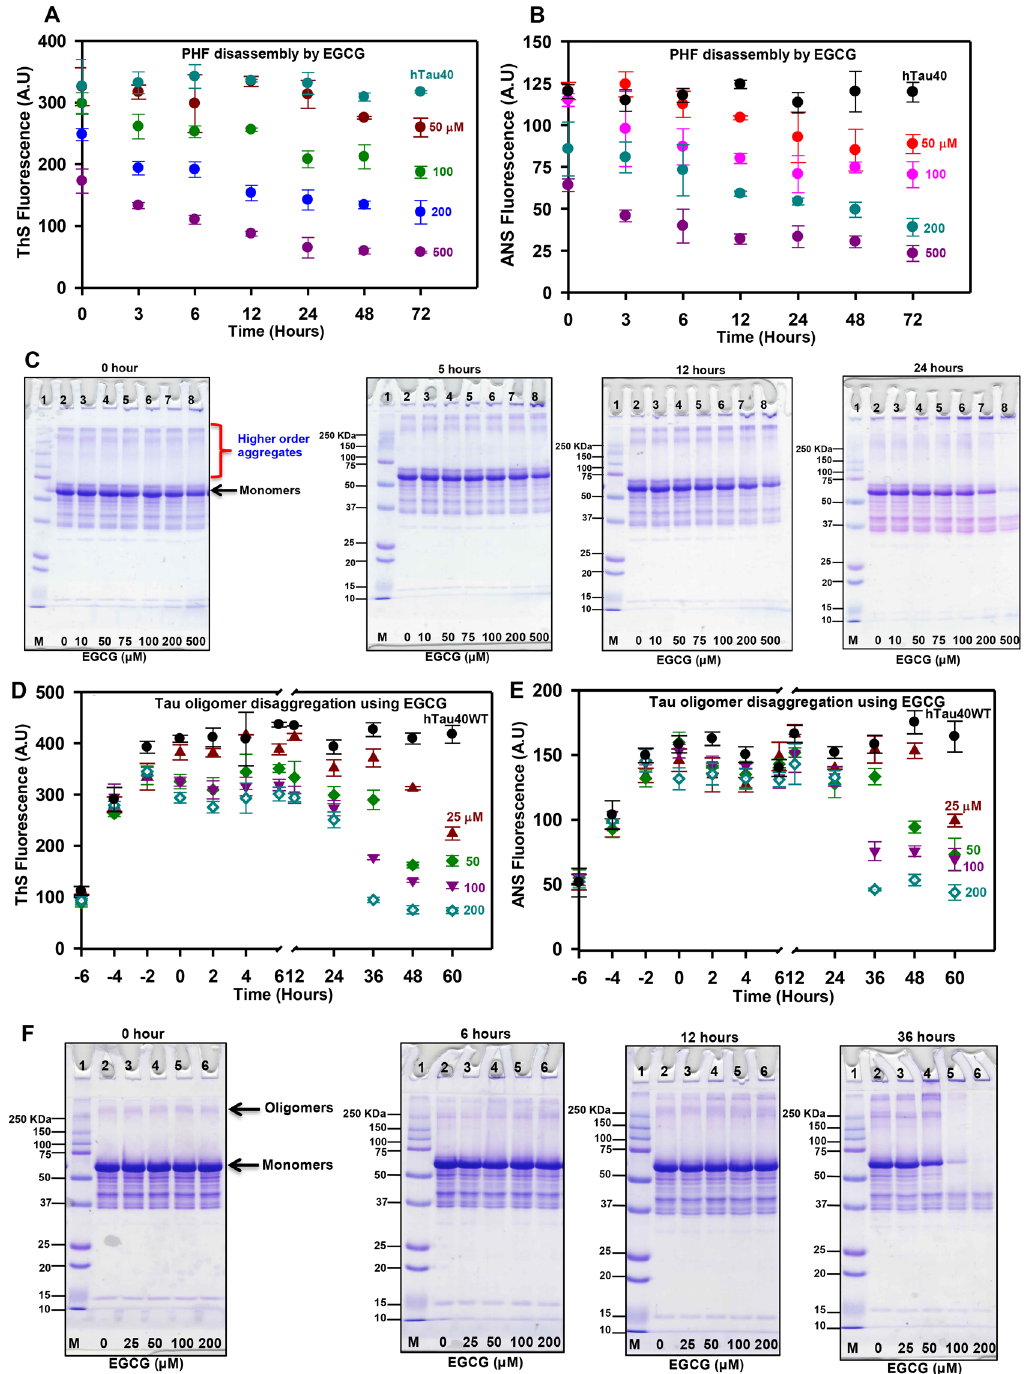
Figure 5. The preformed Tau fibrils and oligomers dissolved by EGCG. ( A ) The EGCG mediated dissolution of mature Tau fibrils recorded by ThS fluorophore showing the disassembly of PHFs. ( B ) The ANS fluorescence shows a time dependent decrease as the fibrils are dissolved. ( C ) The SDS-PAGE analysis of disassembly of Tau PHFs. ( D ) The ThS fluorescence shows the inhibitory effect of EGCG on the dissolution of Tau oligomers in a concentration dependent manner. ( E ) The ANS fluorescence shows the decrease in intensity with time and concentration suggesting loss of hydrophobicity of Tau oligomers. ( F ) The SDS-PAGE analysis shows the presence of oligomers at the time of compound addition (0 h) which are slowly cleared with